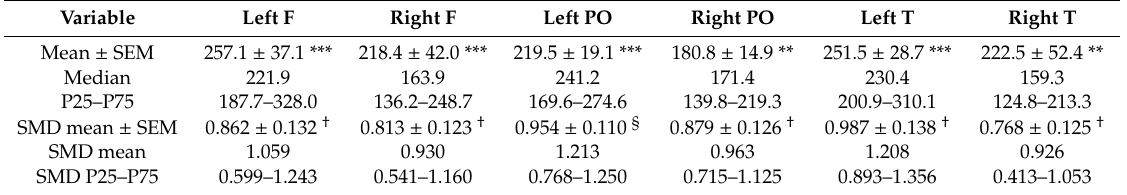
Table A7. Changes in power of theta bands during FS.